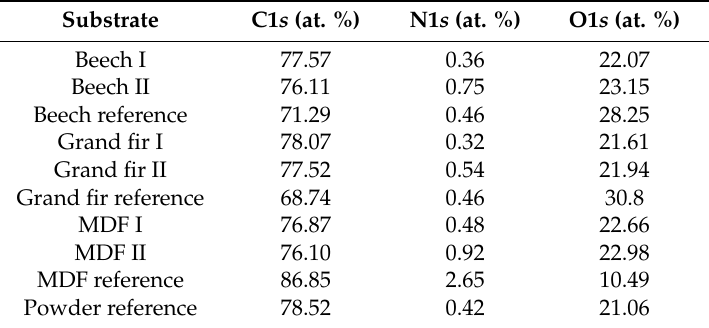
Table 2. Chemical composition of coated wood and wood based materials compared to the reference material (XPS data).